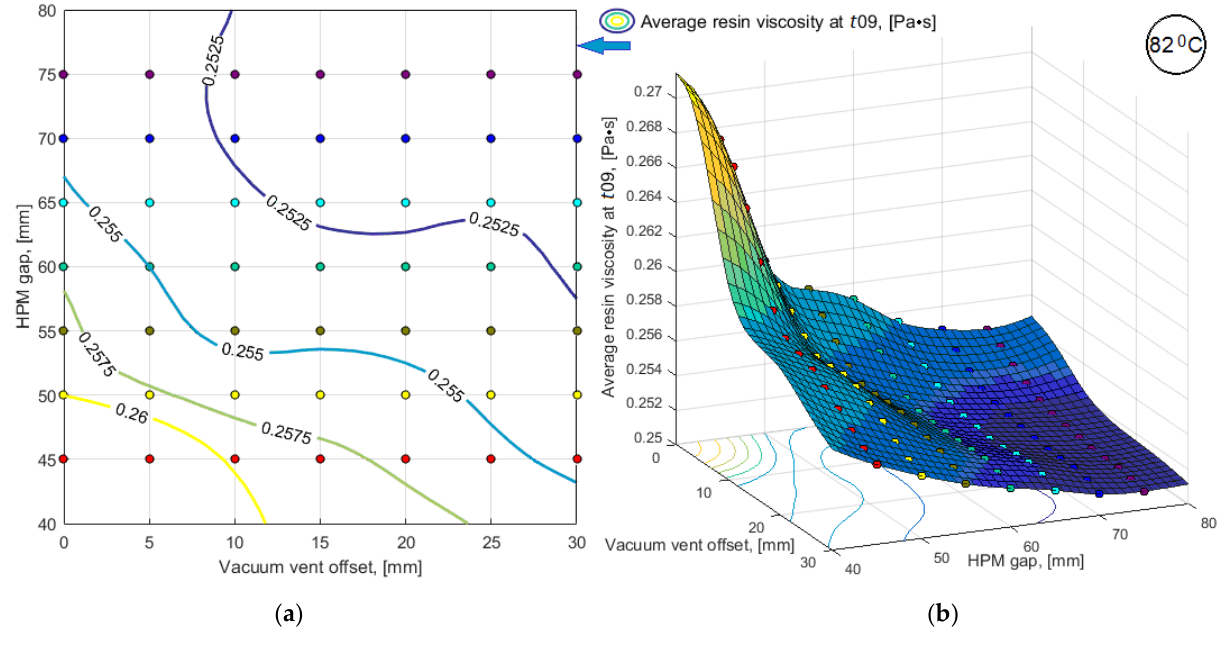
Figure 11. Results of simulation of the predictive sub-criterion < µ ( t 09)> response in the form of: ( a ) map of level lines; ( b ) smoothed 3D function.